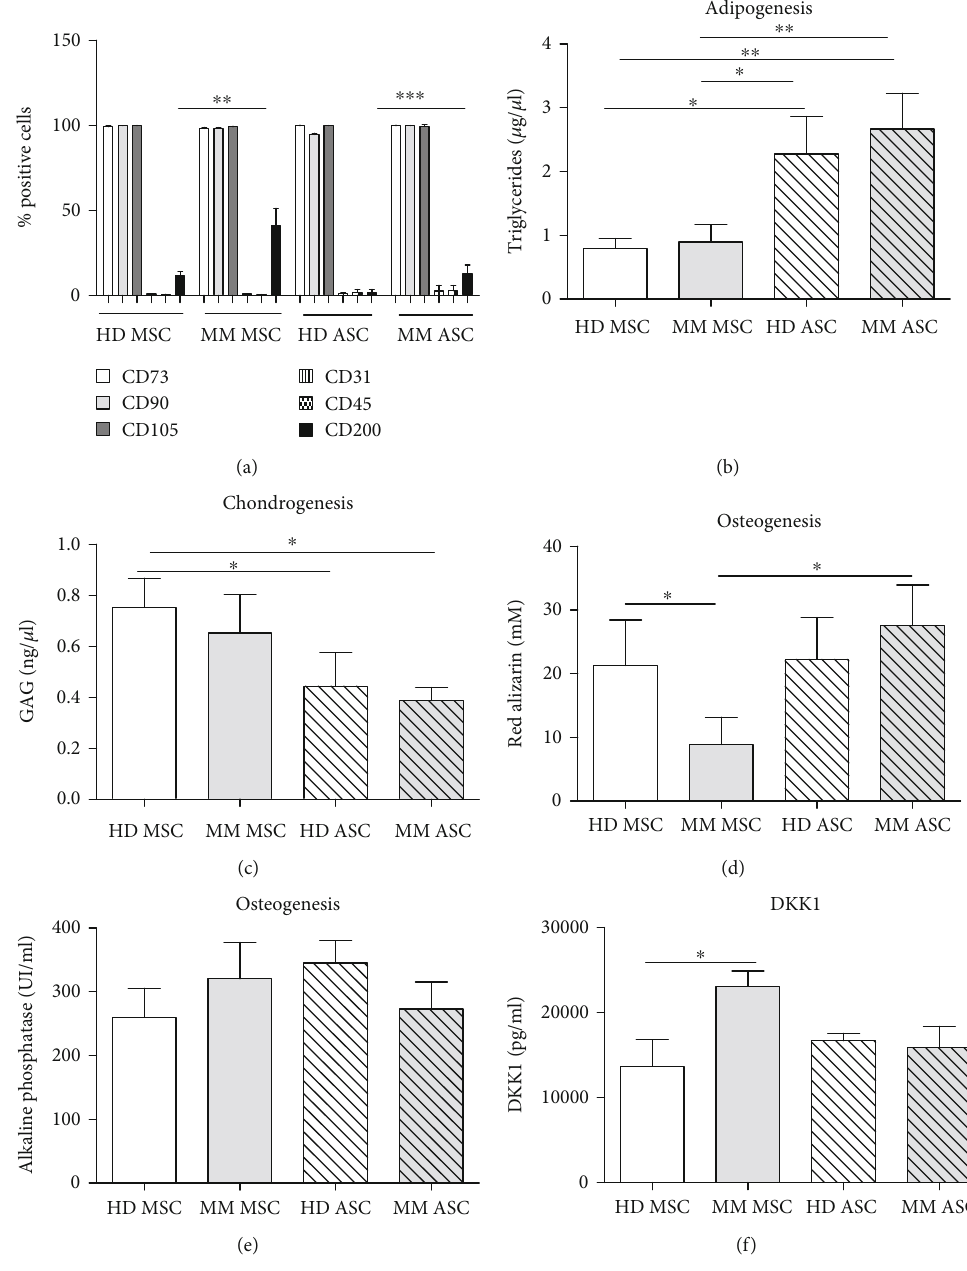
Figure 2: Phenotype and di ff erentiation potential of HD and MM ASCs compared with autologous MSCs. (a) Expression of CD73, CD90, CD105, CD31, CD45, and CD200 in cells after primoculture. Data are mean % positive cells ± SEM ( n = 12 independent experiments). Adipogenic di ff erentiation with triglyceride dosage (b), chondrogenic di ff erentiation with glycosaminoglycan dosage (c), osteoblastic di ff erentiation with quanti fi cation of alizarin red (d), and alkaline phosphatase activity (e) evaluated from all cell sources. Data are the mean ± SEM ( n = 9 independent experiments). (f) DKK1 secretion from HD/MM ASCs or MSCs. Data are the mean ± SEM ( n = 8 independent experiments). ∗ p < 0 : 05 , ∗∗ p < 0 : 01 , ∗∗∗ p < 0 : 001